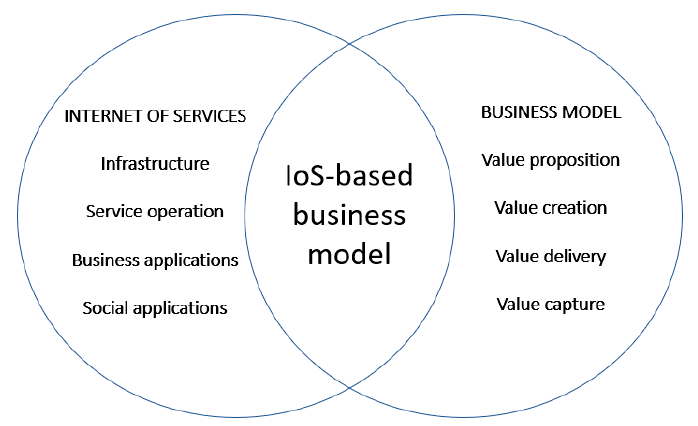
Figure 2. IoS-based business model.